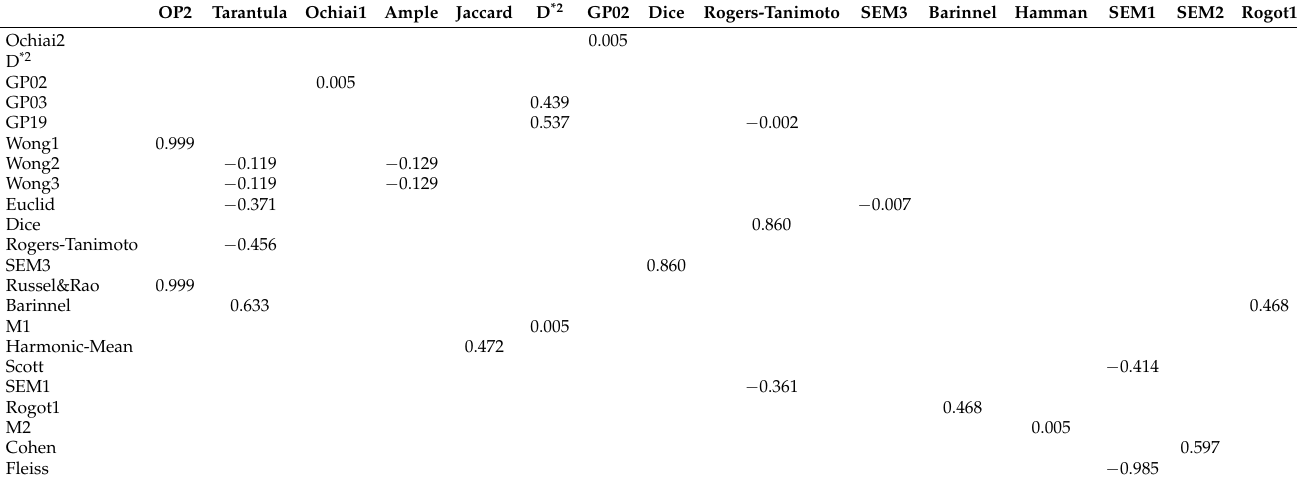
Table 2. The correlation results of the selected combined metrics: p =